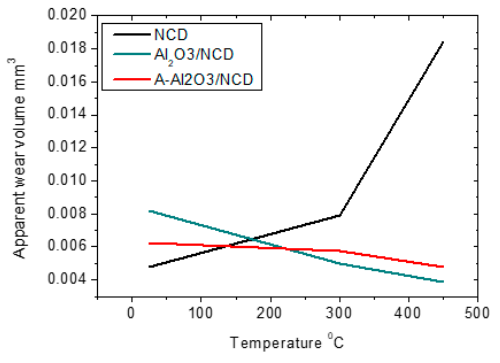
Figure 9. Apparent wear volumes of the wear scars measured on the NCD, Al 2 O 3 /NCD and A-Al 2 O 3 /NCD films.